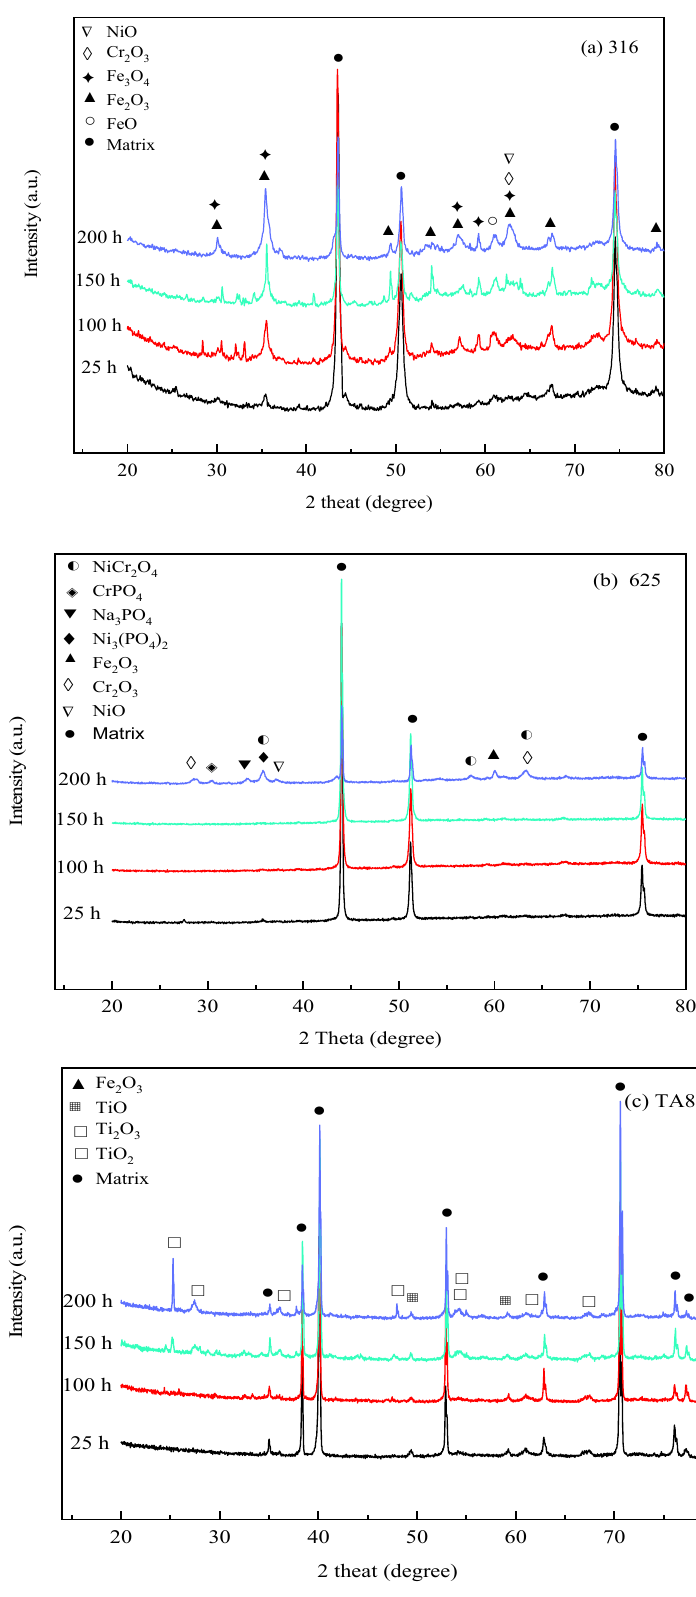
Figure 5. XRD spectra of the specimens after exposure to SCW at 25 h, 100 h, 150 h, and 200 h, respectively; ( a ) 316 SS at the bottom reaction tube; ( b ) Alloy 625 at the bottom reaction tube; ( c ) TA8 at the bottom reaction tube.